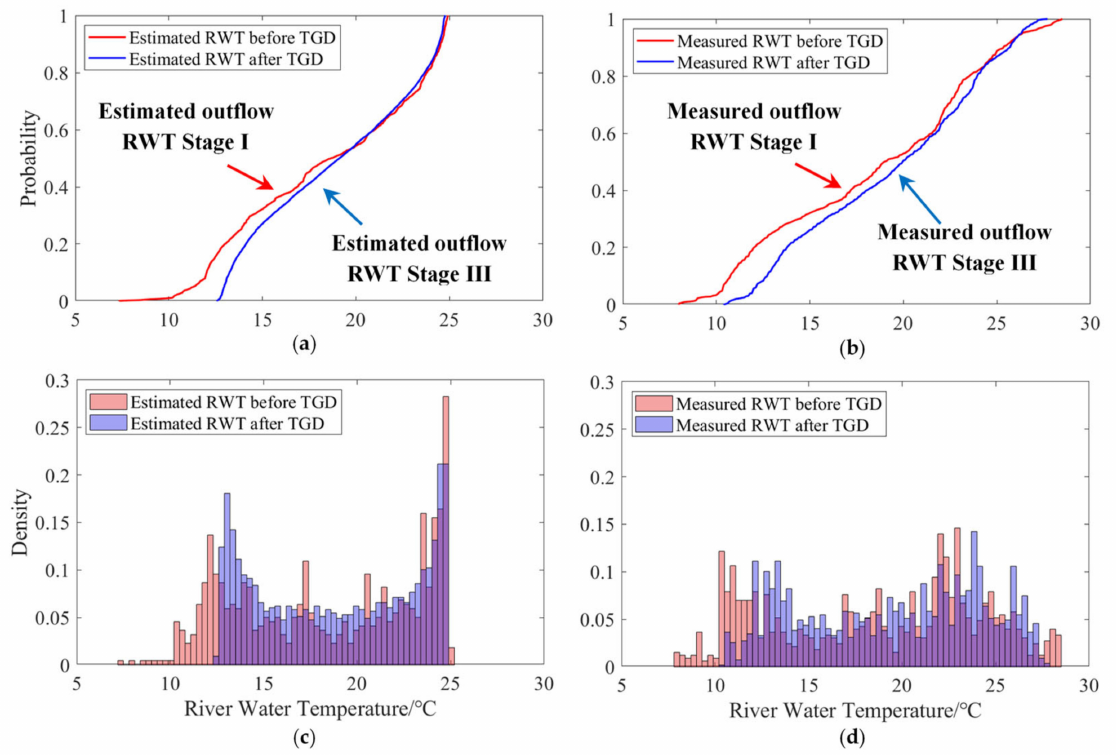
Figure 7. Cumulative probability curves of: ( a ) air2stream estimated RWTs during Stage I and Stage III, ( b ) in situ measured RWTs in Stage I and Stage III, ( c ) density distribution of air2stream estimated RWTs in Stage I and Stage III and ( d ) in situ measured RWT in Stage I and Stage